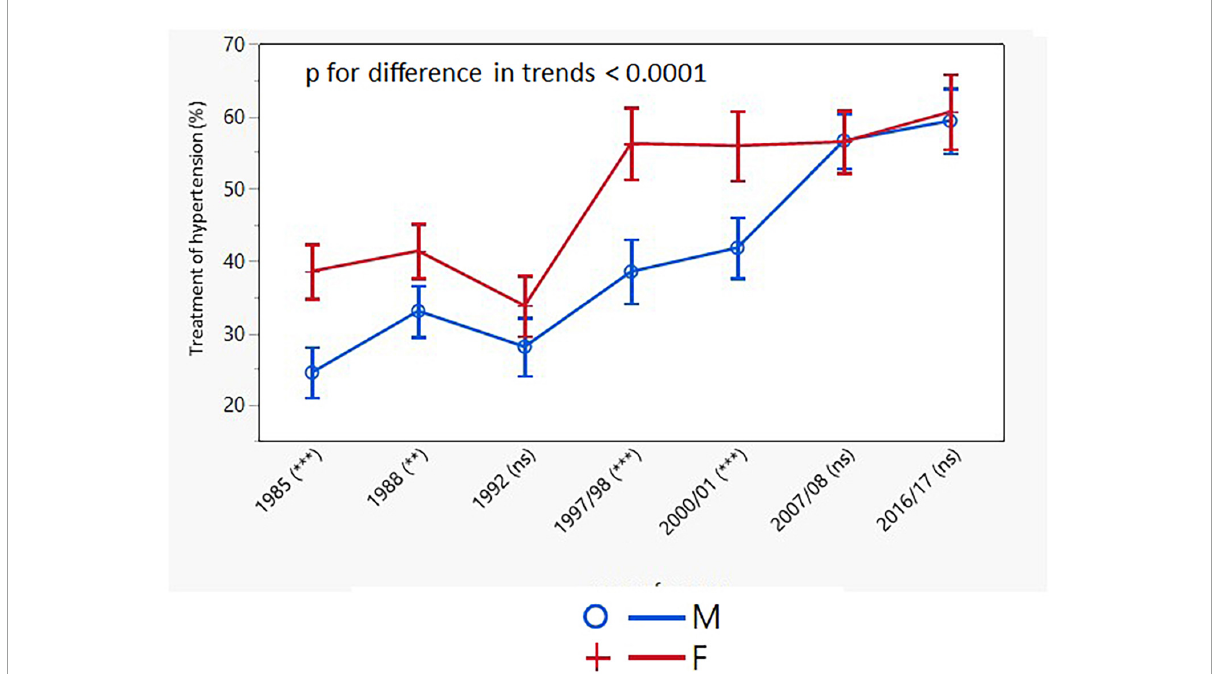
FIGURE6 Age-adjusted trends in treatment of hypertension (95% confidence interval). M, males; F, females; p for differences in trends between males and females. NS or asterisks indicates in brackets after survey years the sex differences in respective surveys after Bonferroni correction; ** p < 0.01; *** p <